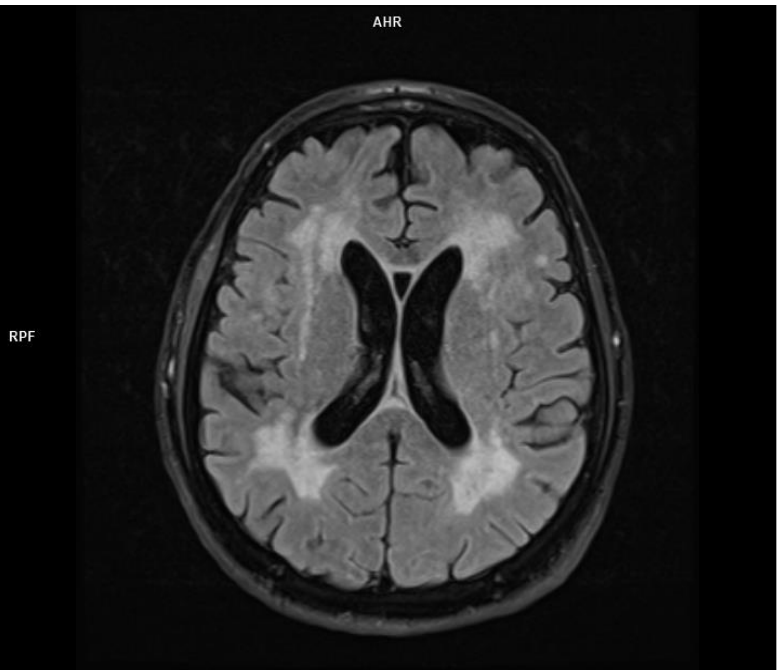
Figure 3. Moderate cortical atrophy and supratentorial ventricular system dilatation—Flair sequence (MRI imaging).